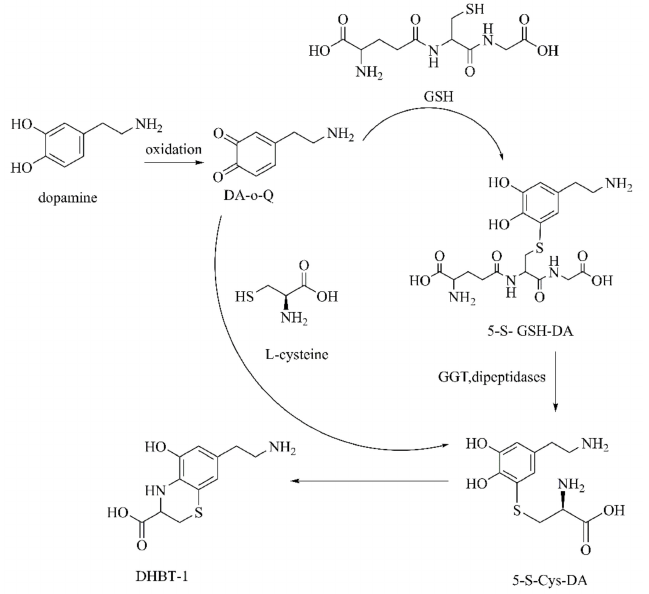
Figure 13. The reaction of DA-o-Q with biomolecules containing sulfur [97].